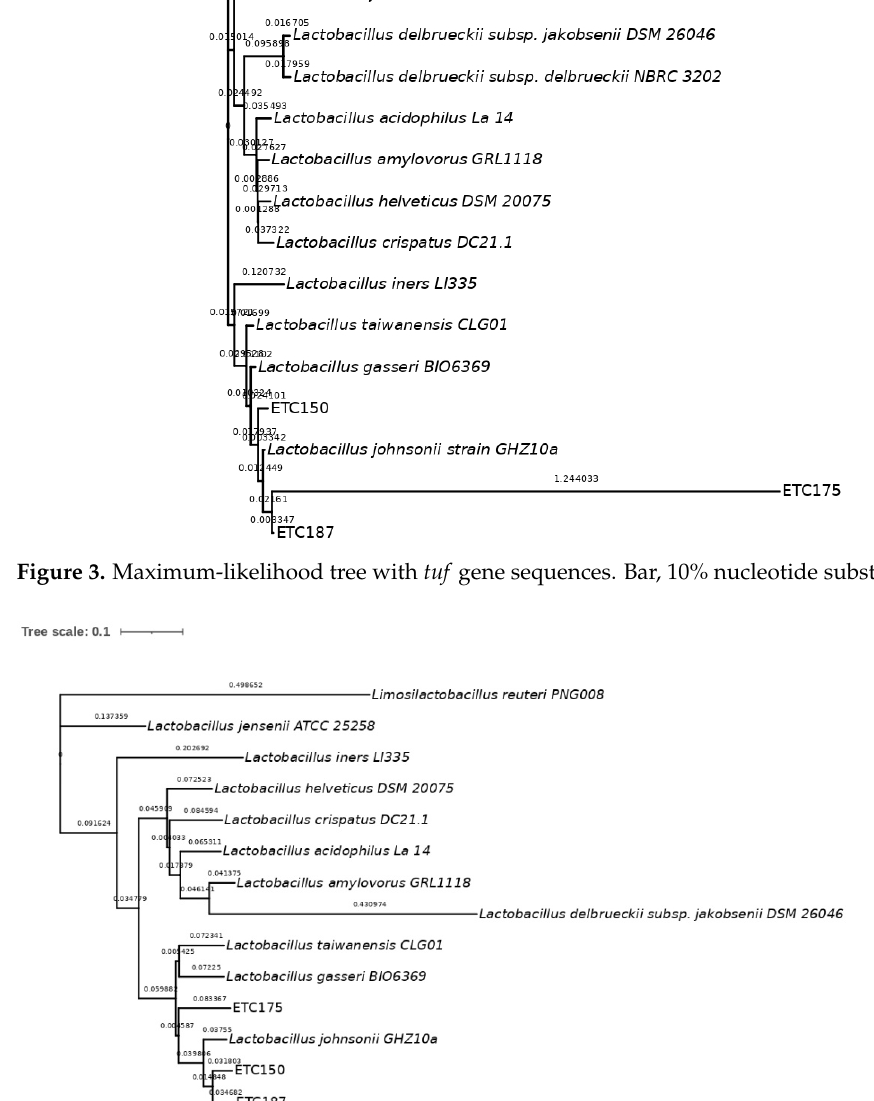
Figure 4. Maximum-likelihood tree with pyrG gene sequences. Bar, 10% nucleotide substitutions.